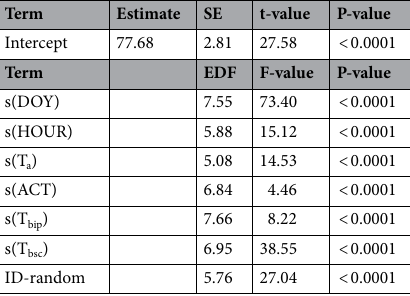
Table 1. Results from a GAMM multiple regression model testing for effects on mean hourly heartrate. The effective degree of freedom (EDF) is an index of the “wiggliness” of the term-effect. The adjusted R 2 of the model was 0.349. F-values represent an in index of relative variable importance.